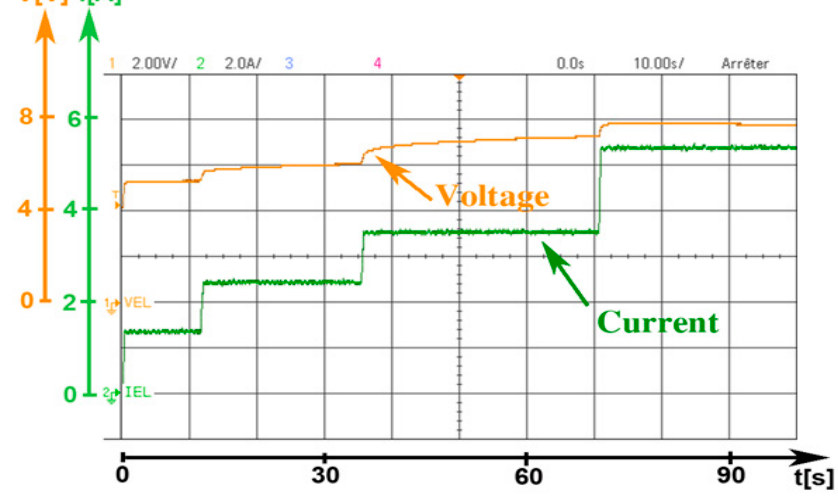
Figure 5. Operating limits of the PEM EL. Channel 1: EL voltage (2 V.div − 1 ), channel 2: EL current (2 A.div − 1 ), time: 10 s.div − 1 .